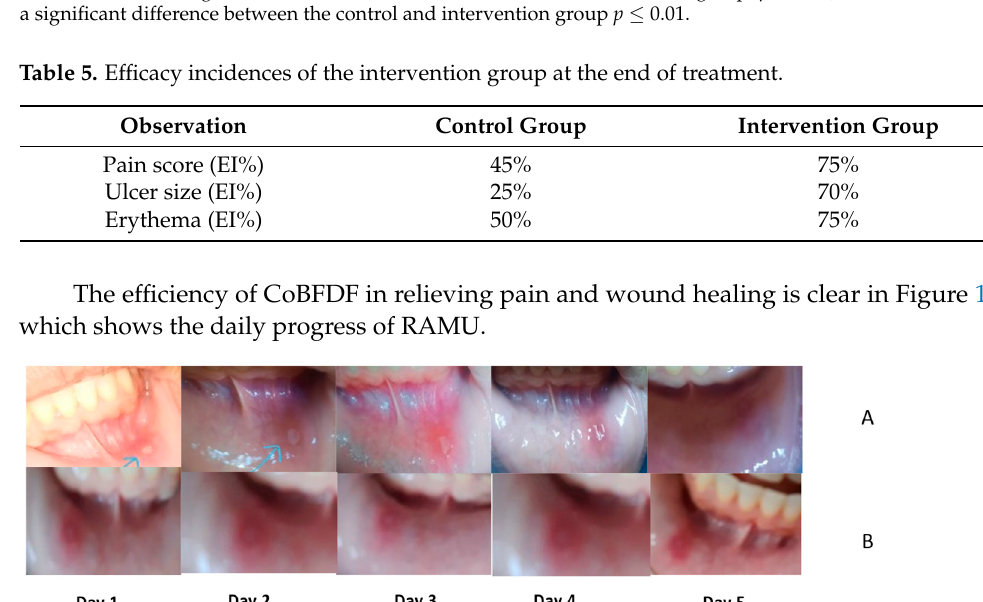
Figure 11. Daily progress in RAMU healing in ( A ) intervention group, ( B ) control group.